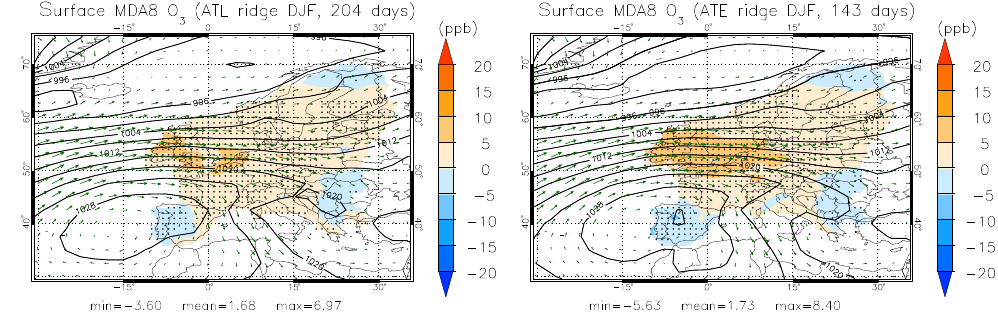
Figure 12. As Fig. 4 but for subtropical ridge centres in the Atlantic (30–0 ◦ W, left) and east Atlantic (15–0 ◦ W, right) in